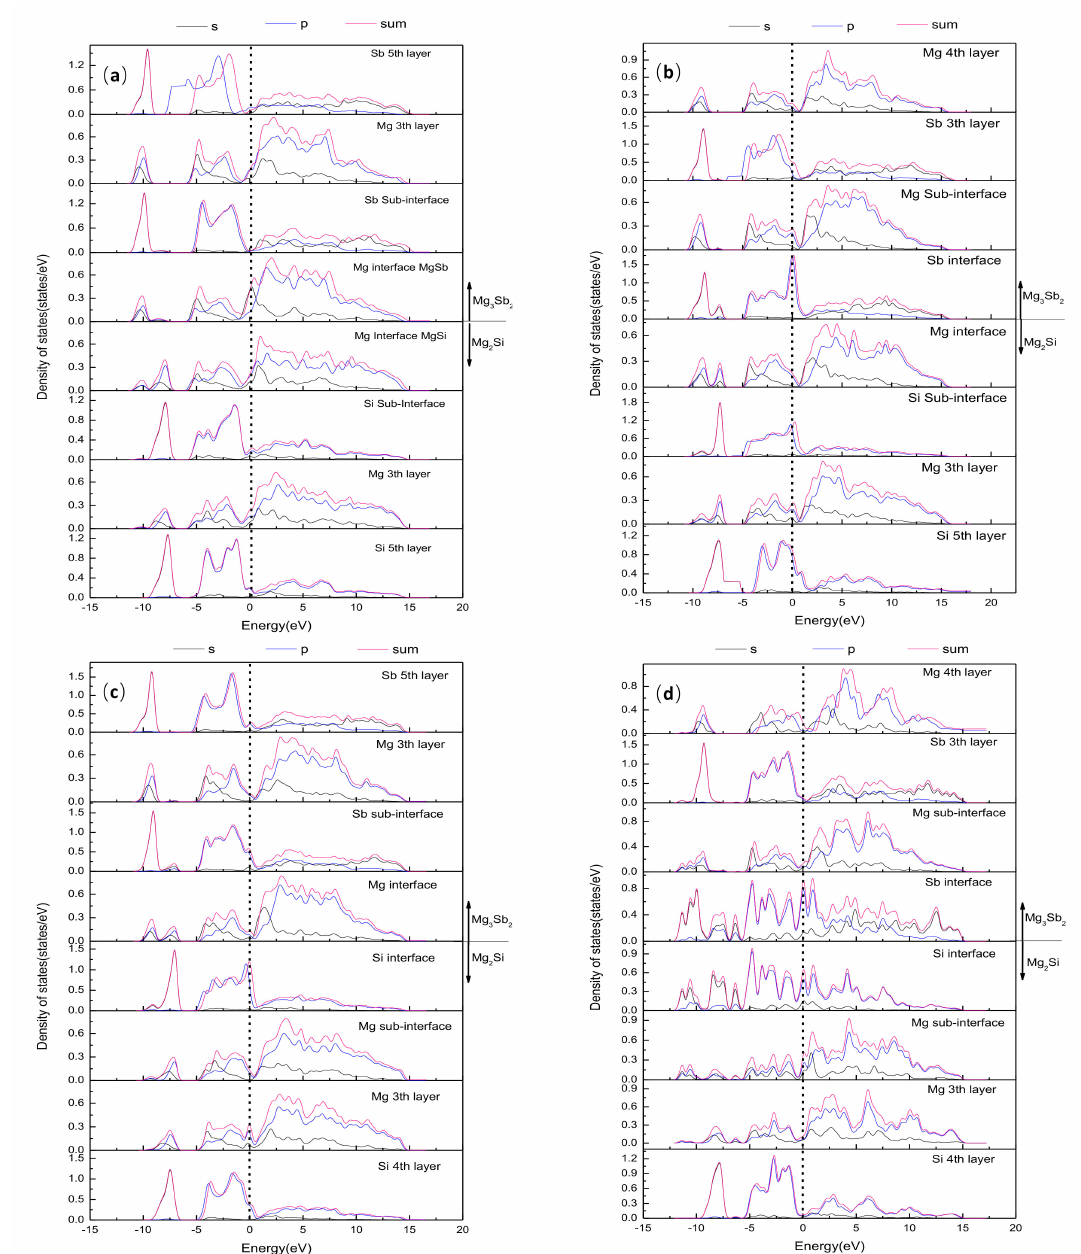
Figure 9. The layer-projected partial density of states (PDOS) for the Mg 3 Sb 2 (0001) / Mg 2 Si (111) interface with hollow-sited stacking. The ( a ) Mg–HCP–Mg interface, ( b ) Mg–HCP–Sb interface, ( c ) Si–HCP–Mg interface, and ( d ) Si–HCP–Sb interface. The dotted line refers to the Fermi